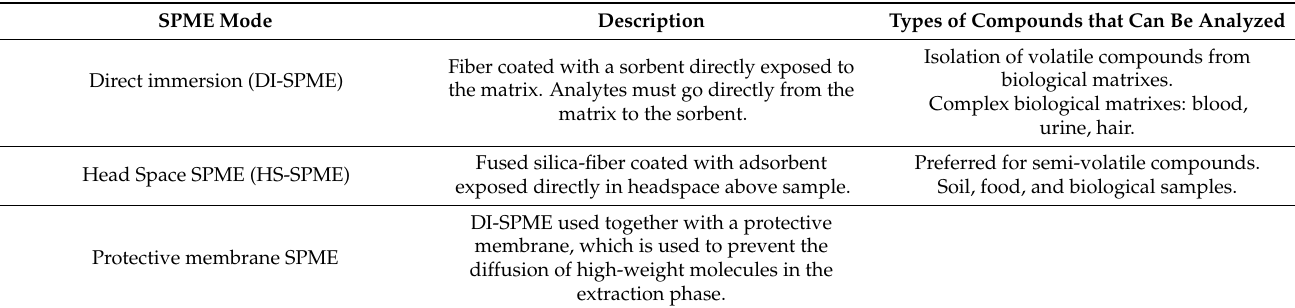
Table 3. Main modes in which SPME can be